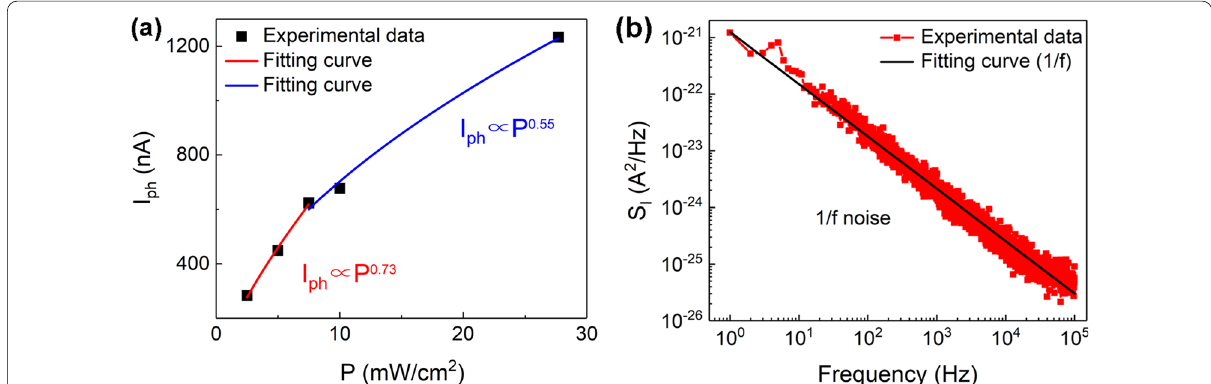
Fig. 4 (a) The plot of I ph versus laser power densities. ( b) The current power spectrum ( S I ) under different frequencies. The applied voltage for ( a–b ) is 1 V